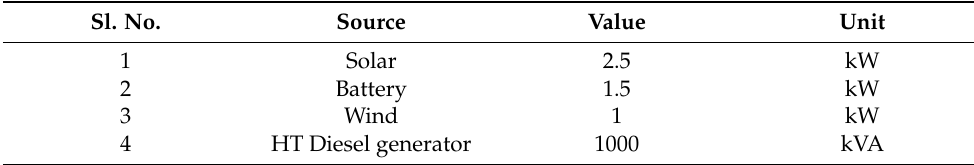
Table 2. Various DGs of the microgrid system.